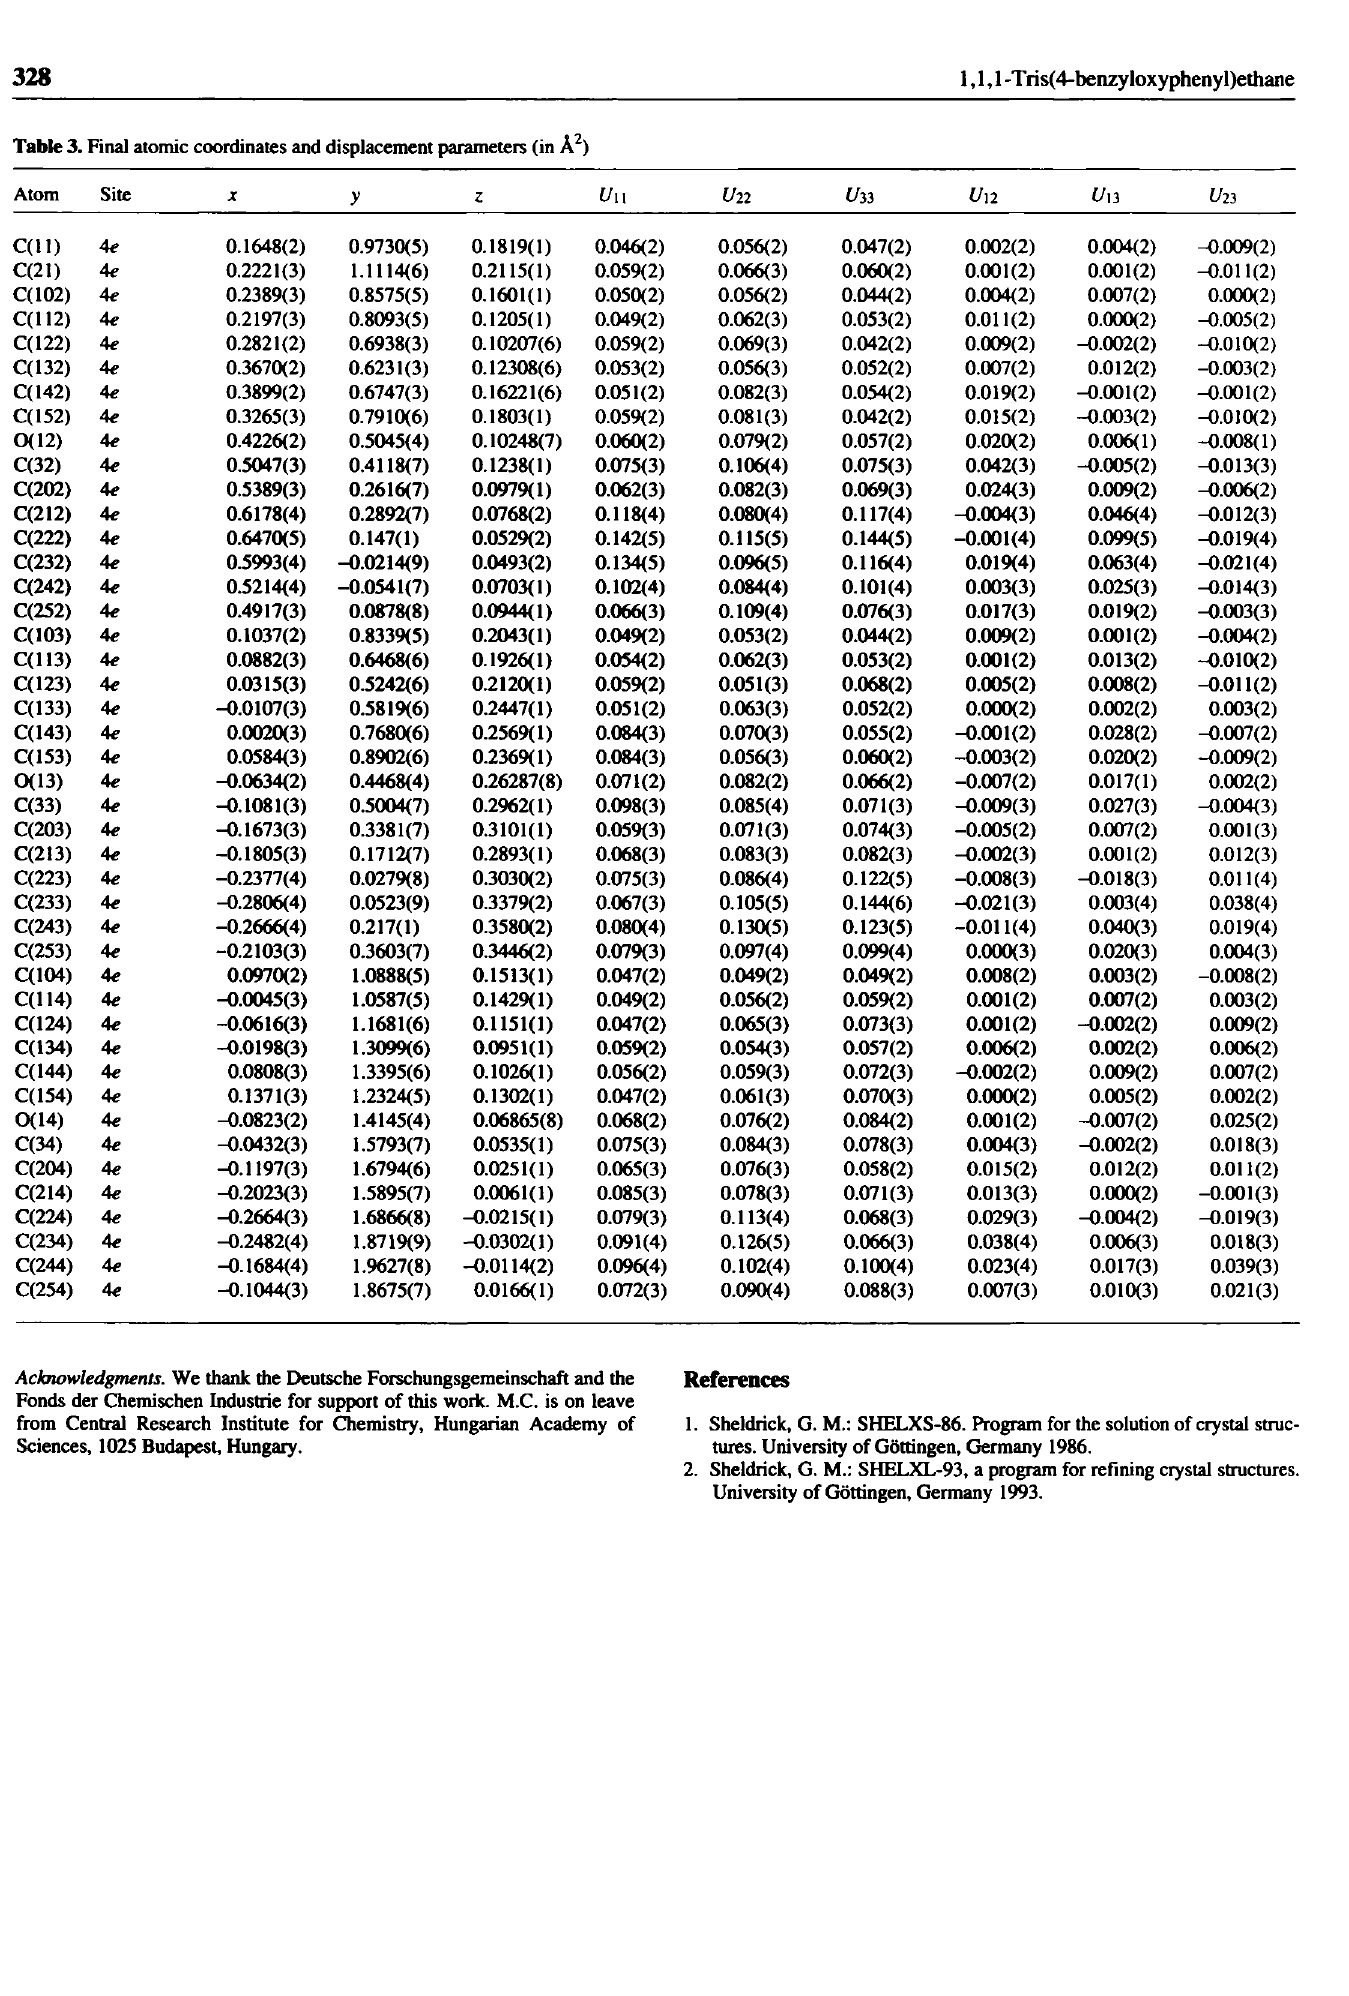
Table 3. Final atomic coordinates and displacement parameters (in Â 2 ) Atom